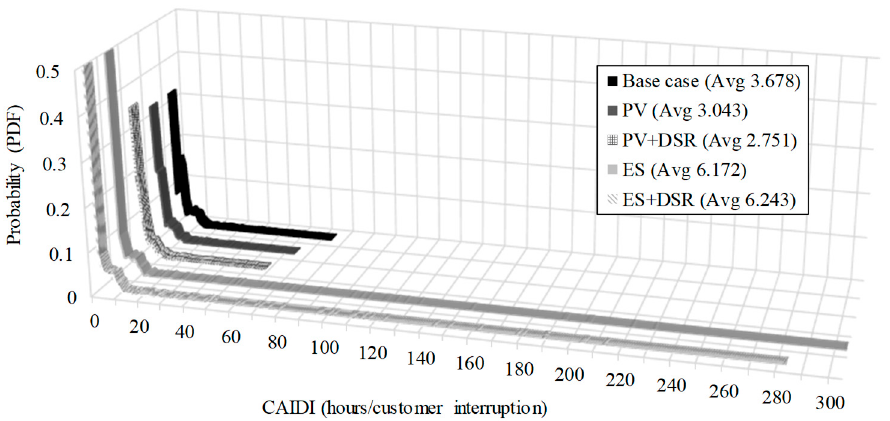
Figure 16. Comparison of PDFs for CAIDI index.